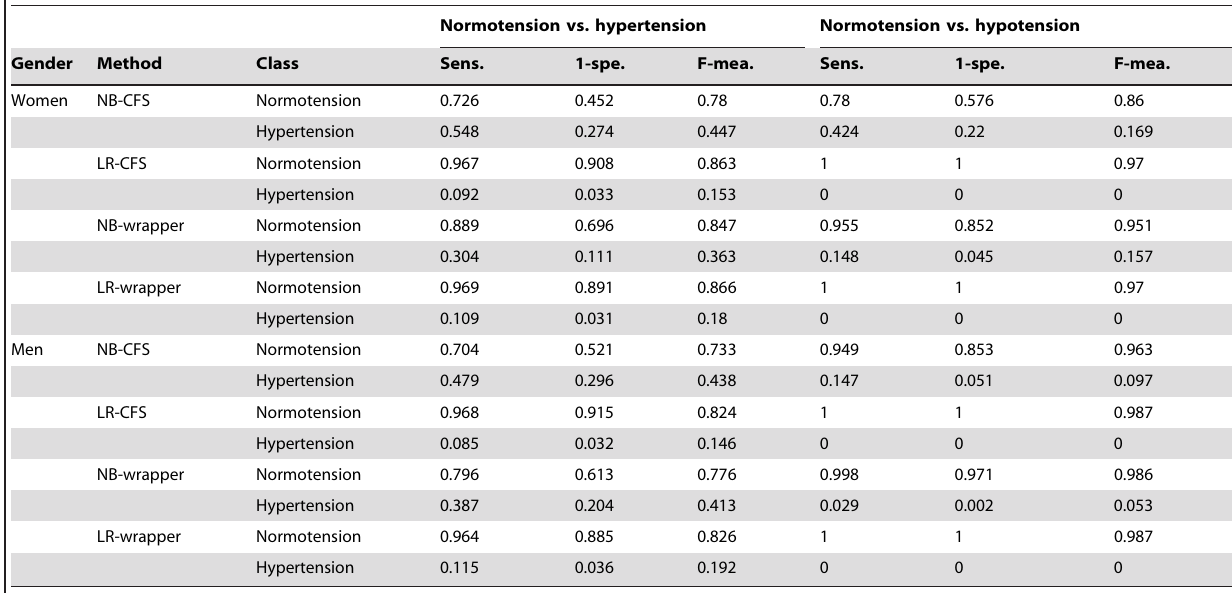
Table 4. Detailed results of prediction experiments using combined indices.